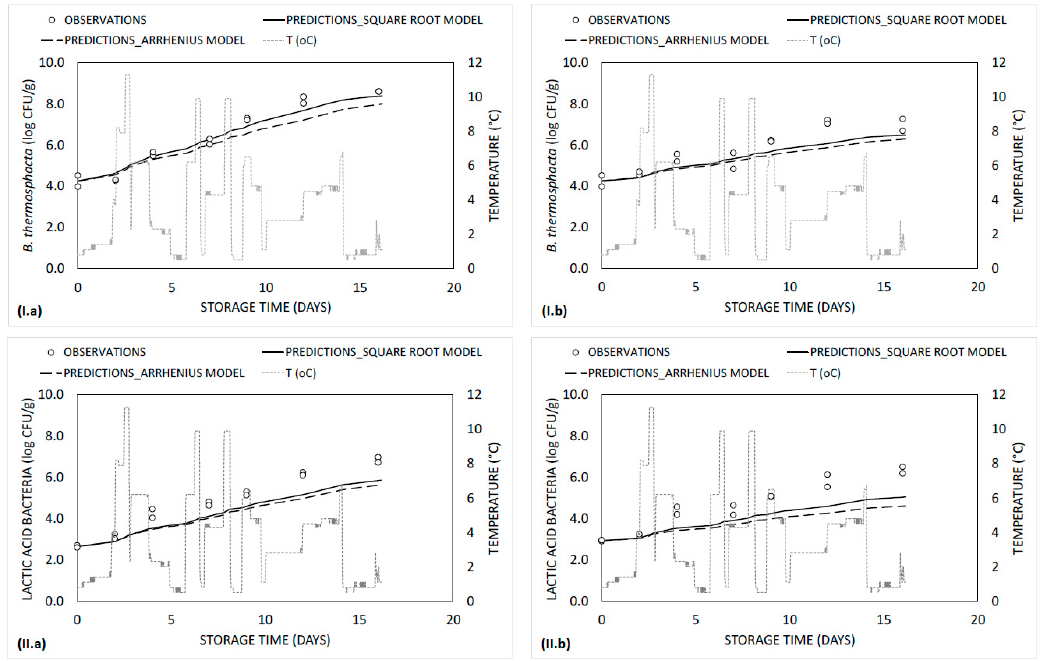
Figure 4. Simulated growth curves and observed data of ( I ) B. thermosphacta and ( II ) LAB in ground beef (500 g) packaged ( a ) without (controls) or ( b ) with absorbent pads supplemented with a total volume of 50 mL “ tsipouro ” (40 mL under the ground beef piece and 10 mL under the labelling, facing the headspace) under 80% O 2 : 20% CO 2 and stored at dynamic temperature conditions.